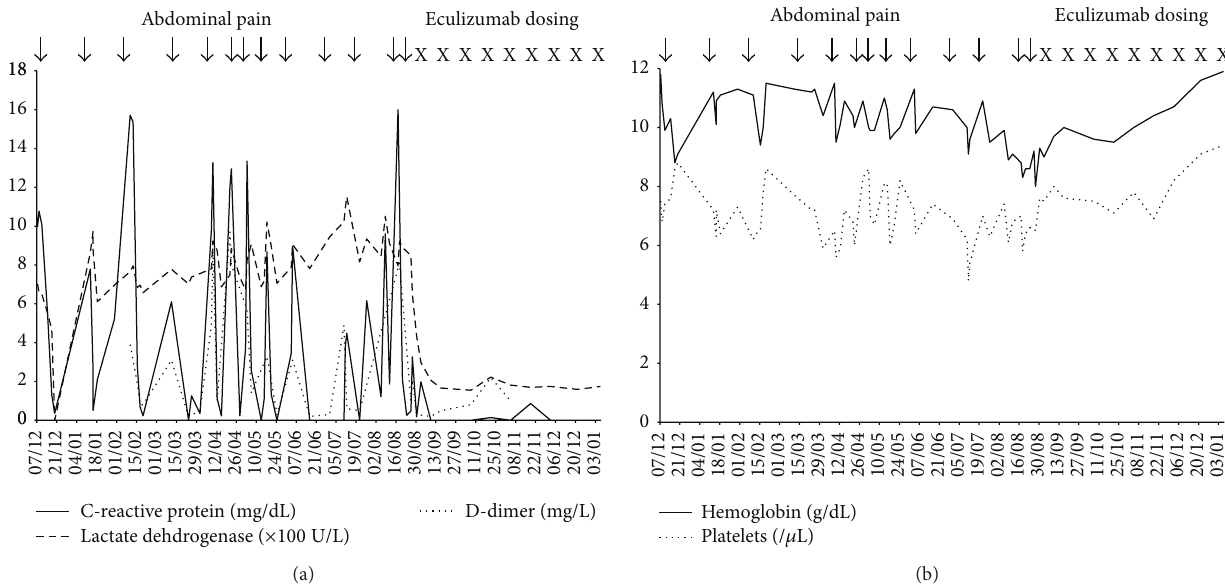
Figure 2: Clinical course from December 2009 to January 2011. (a) C-reactive protein, lactate dehydrogenase, and D-dimer levels. (b) Hemoglobin and platelet